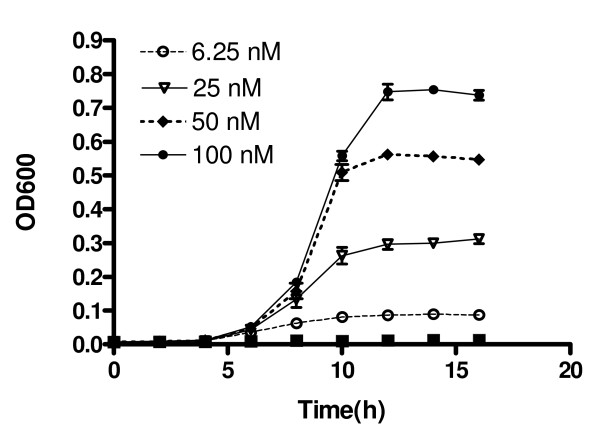
Growth curves of TA100 cells in minimal medium that contained different concentrations of histidine. Data are expressed as means ± SD of three individual experiments.